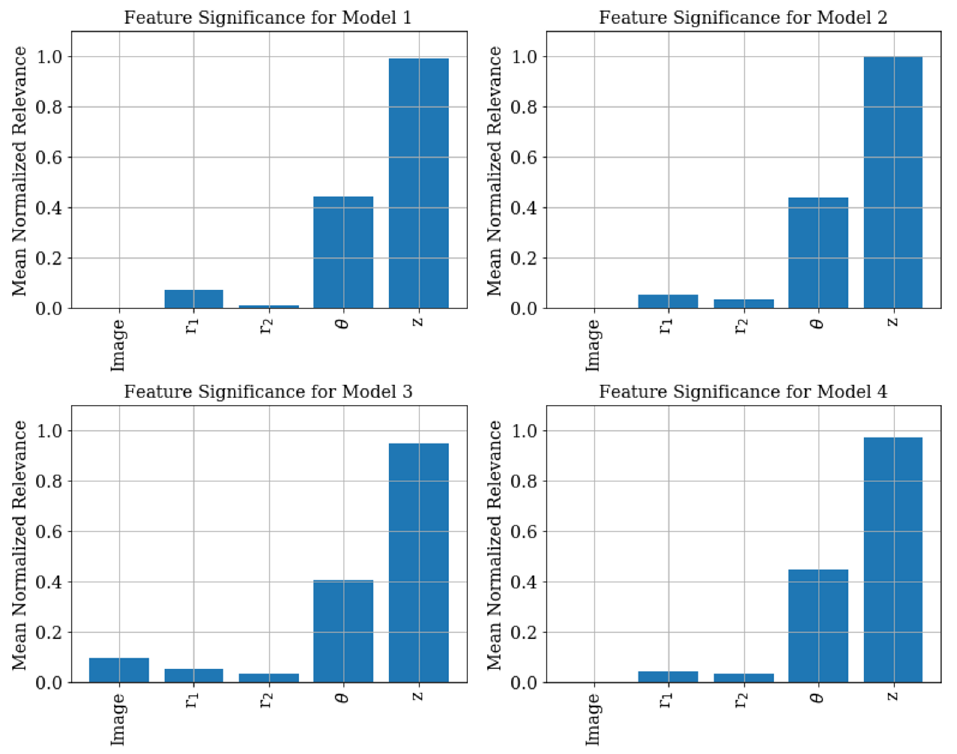
Figure 11. LRP scores for all variables in the Toy 2D CNN Model, with 4 separate trained